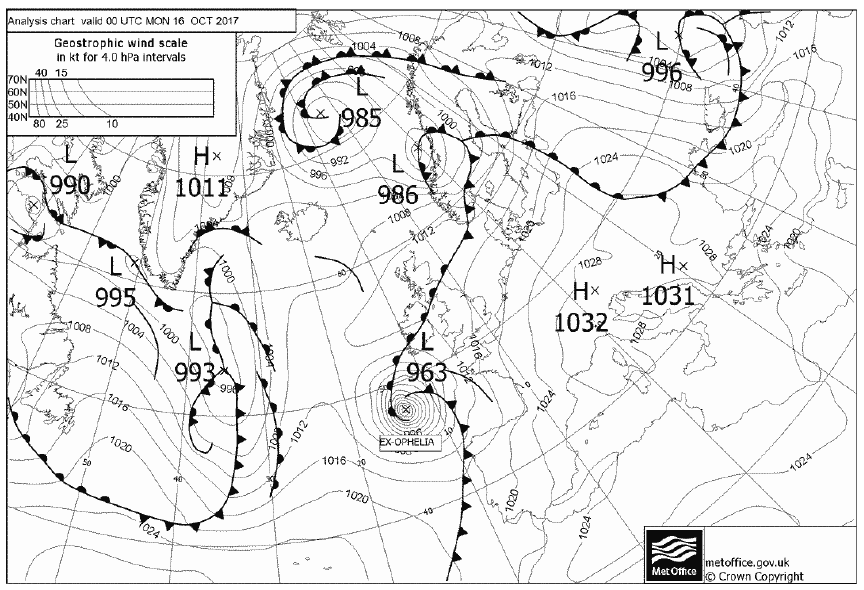
Figure 2. Met Office synoptic analysis chart for 00:00UTC on Monday 16 October 2017 showing sea-level pressure and the frontal system associated with Ophelia.